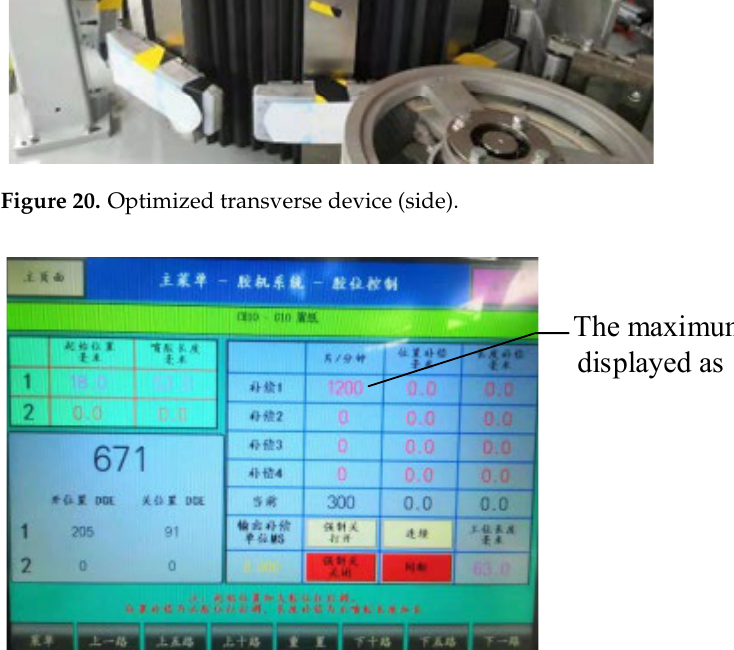
Figure 21. The maximum running speed of the transverse device.